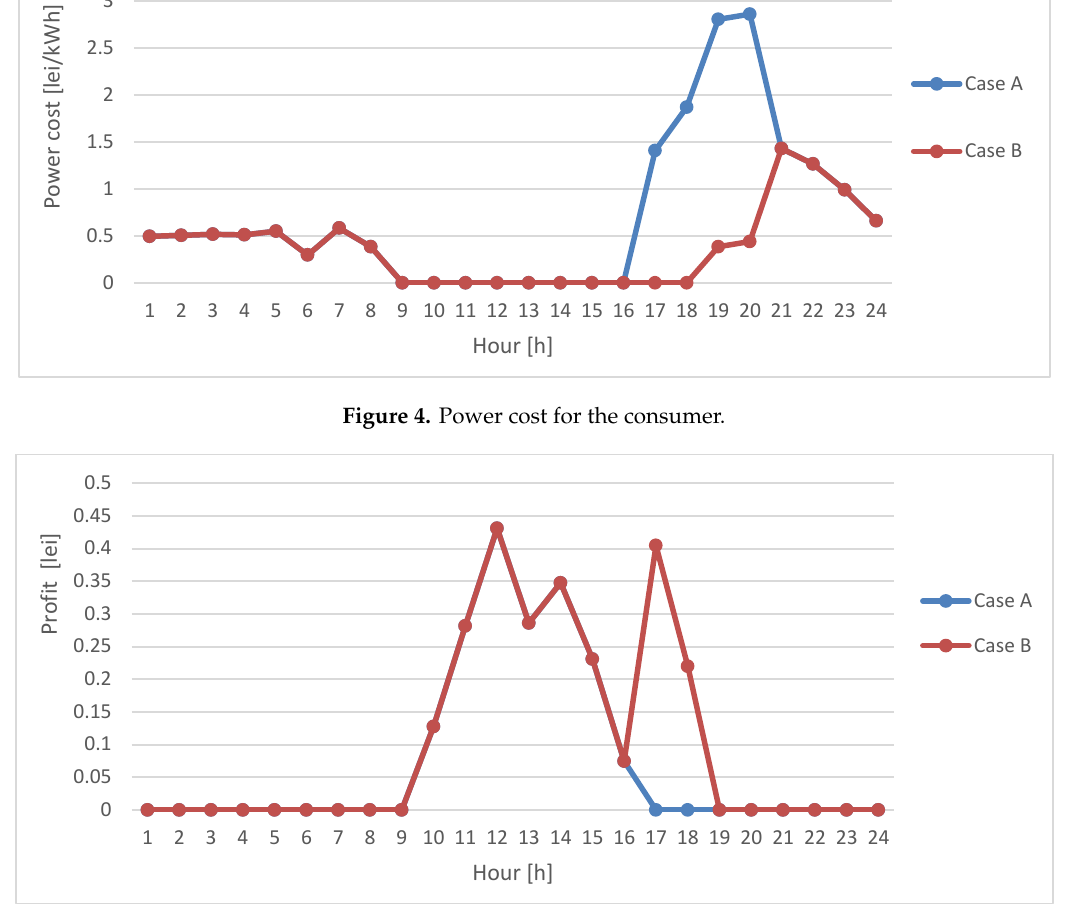
Figure 5. Consumer profit.